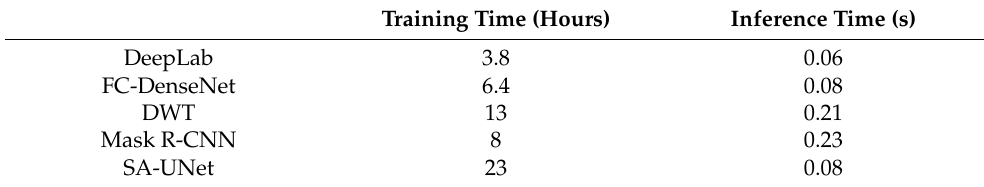
Table 4. Training and inference times of the models.